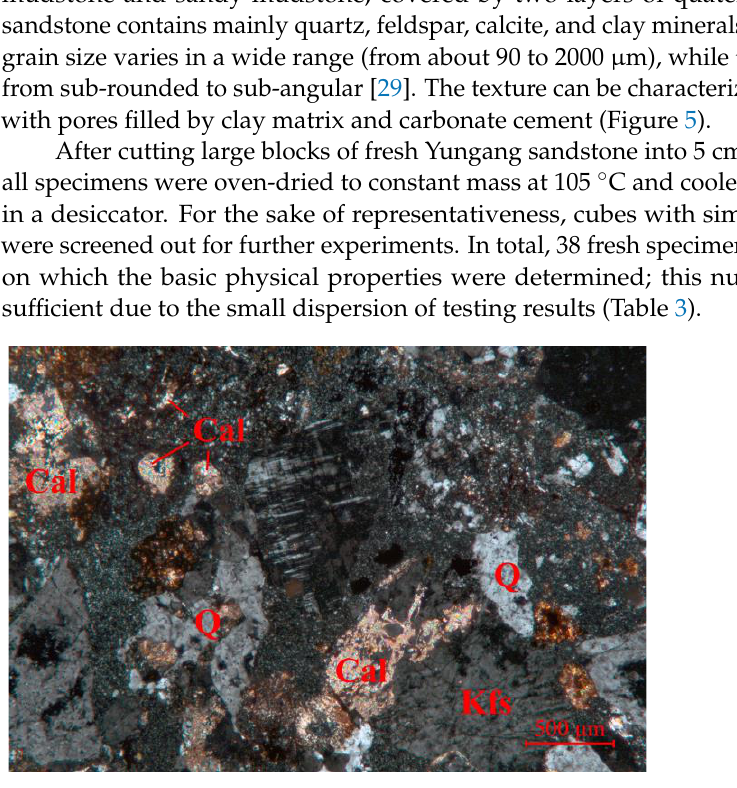
Figure 5. Photomicrograph of the texture of fresh Yungang sandstone (Q = quartz, Cal = calcite, and Kfs = K-feldspar). Table 3. Basic physical properties of fresh Yungang